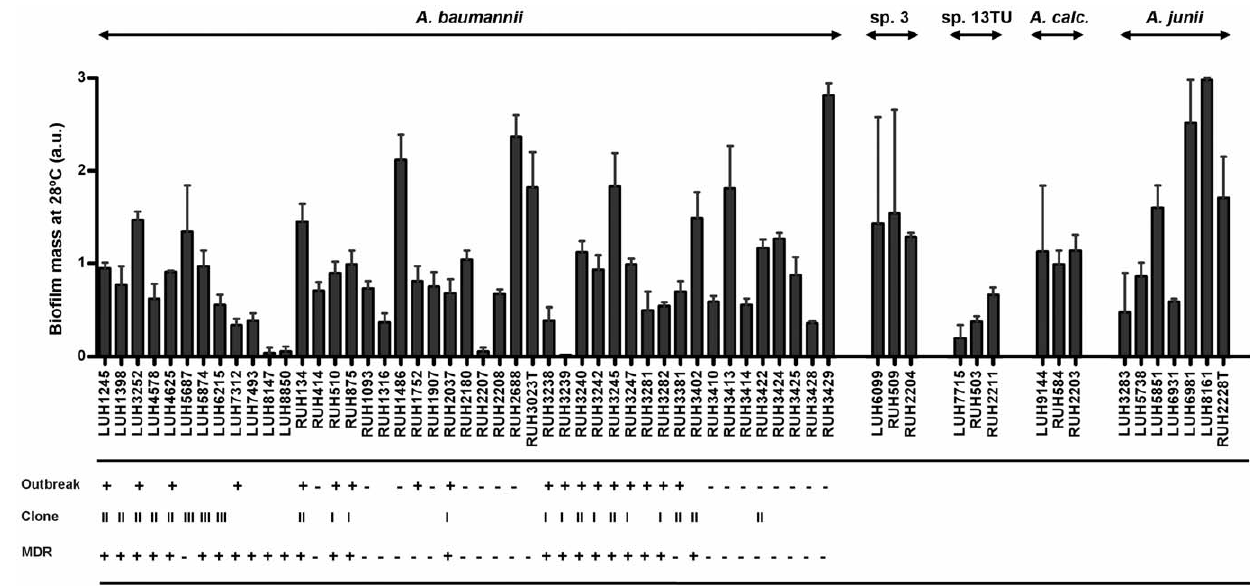
Figure 1. Biofilm formation by Acinetobacter. Biofilm formation after 24 h at 28 u C for the clinically relevant A. baumannii (n=45), A. gen. sp. 3 (n=3) and A. gen. sp. 13TU (n=3) and for the clinically less-relevant A. calcoaceticus (n=3) and A. junii (n=7). Data are expressed as mean biofilm mass (in arbitrary units (a.u.)) of three independent experiments; each performed in sixplicate. Outbreak-associated ( + ) or non-outbreak-associated ( 2 ) isolate. European clone I (I), II (II) or III (III) isolate. Multidrug resistant (MDR; + ) or susceptible ( 2 ) isolate.